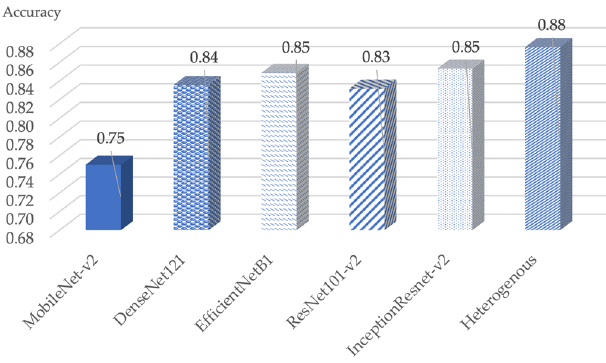
Figure 11. The accuracy of various classification methods.